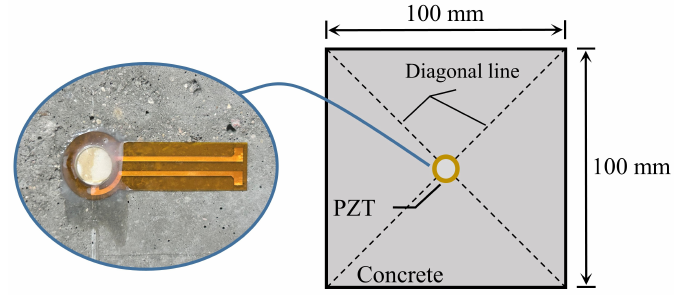
Figure 1. Placement of PZT.